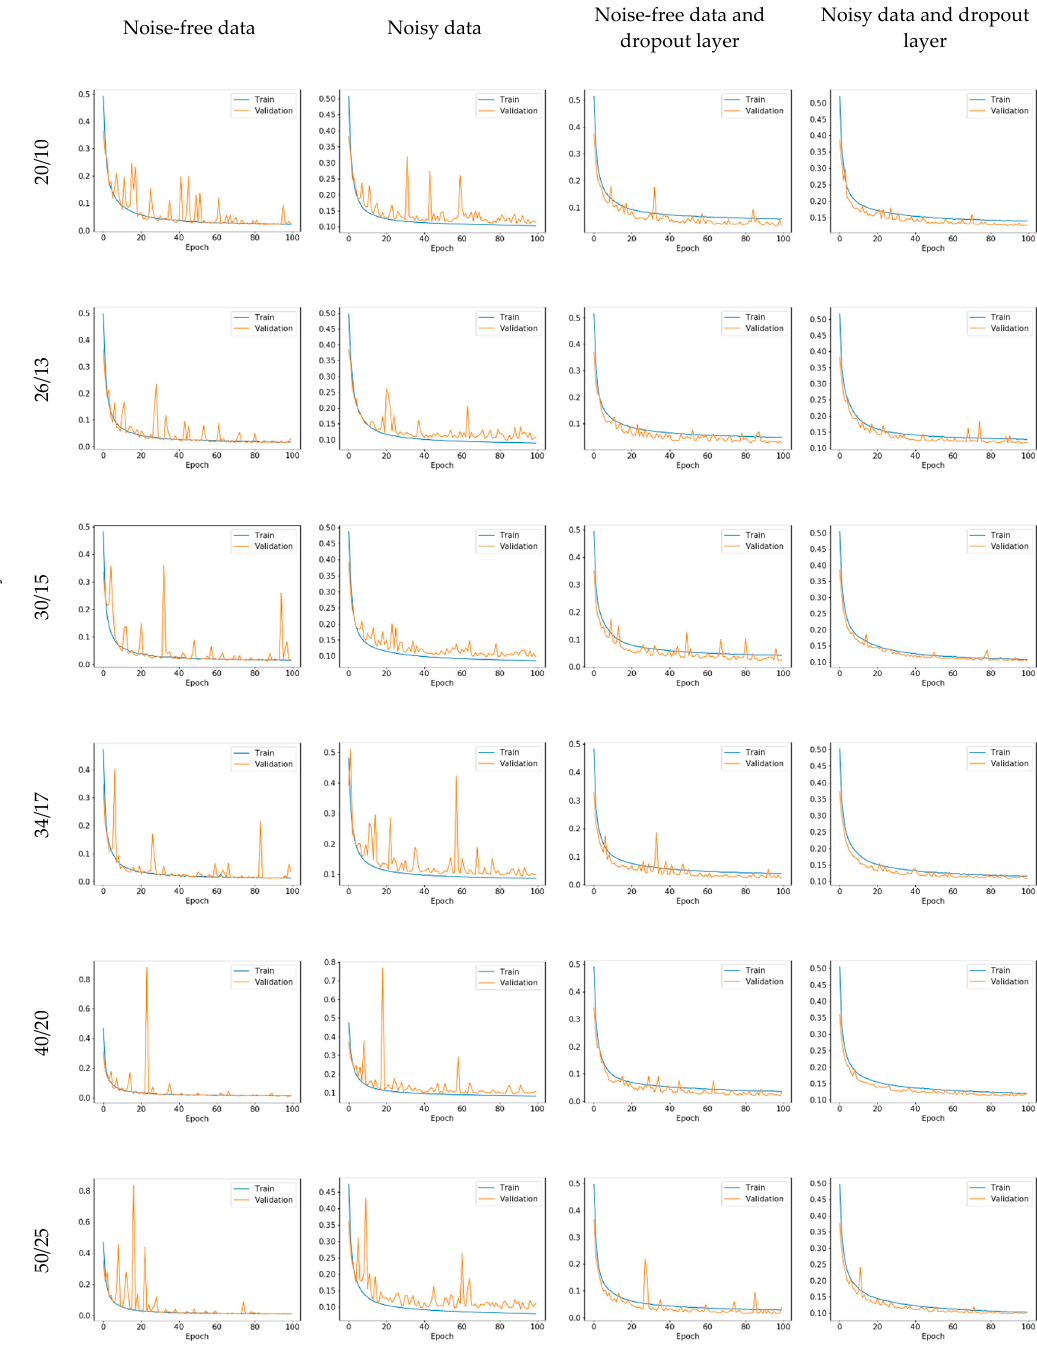
Figure 7. Learning curves for various three-layer MLP configurations—training set scores in blue, validation set scores in orange. The plots in the first two and two second two columns correspond to architectures without and with the dropout layer, respectively. The curves in columns 1 and 3 were obtained for the noise-free training data, whereas in columns 2 and 4 for the data corrupted with Gaussian noise.